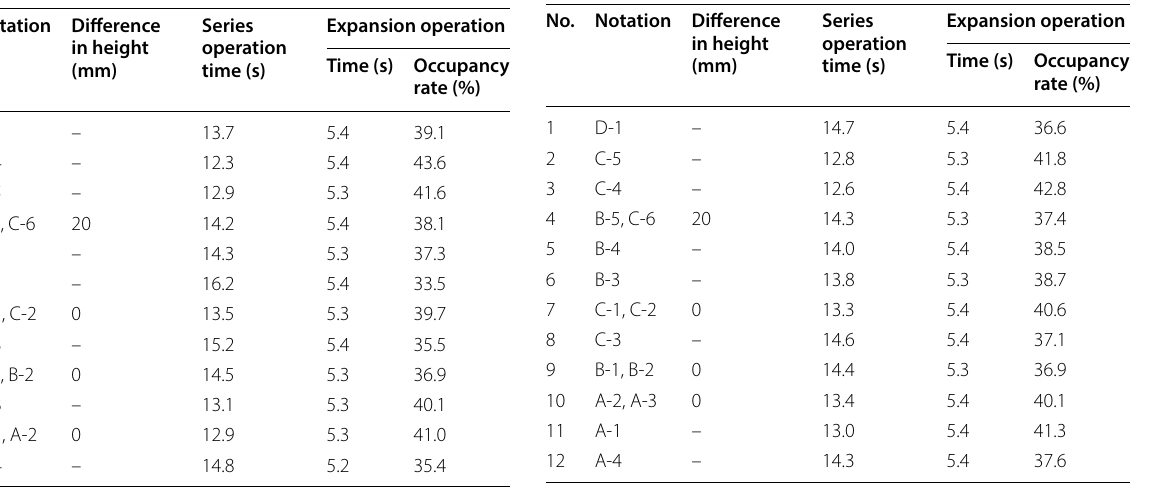
Table 6 Continuous unloading experiment results ① Table 7 Continuous unloading experiment results